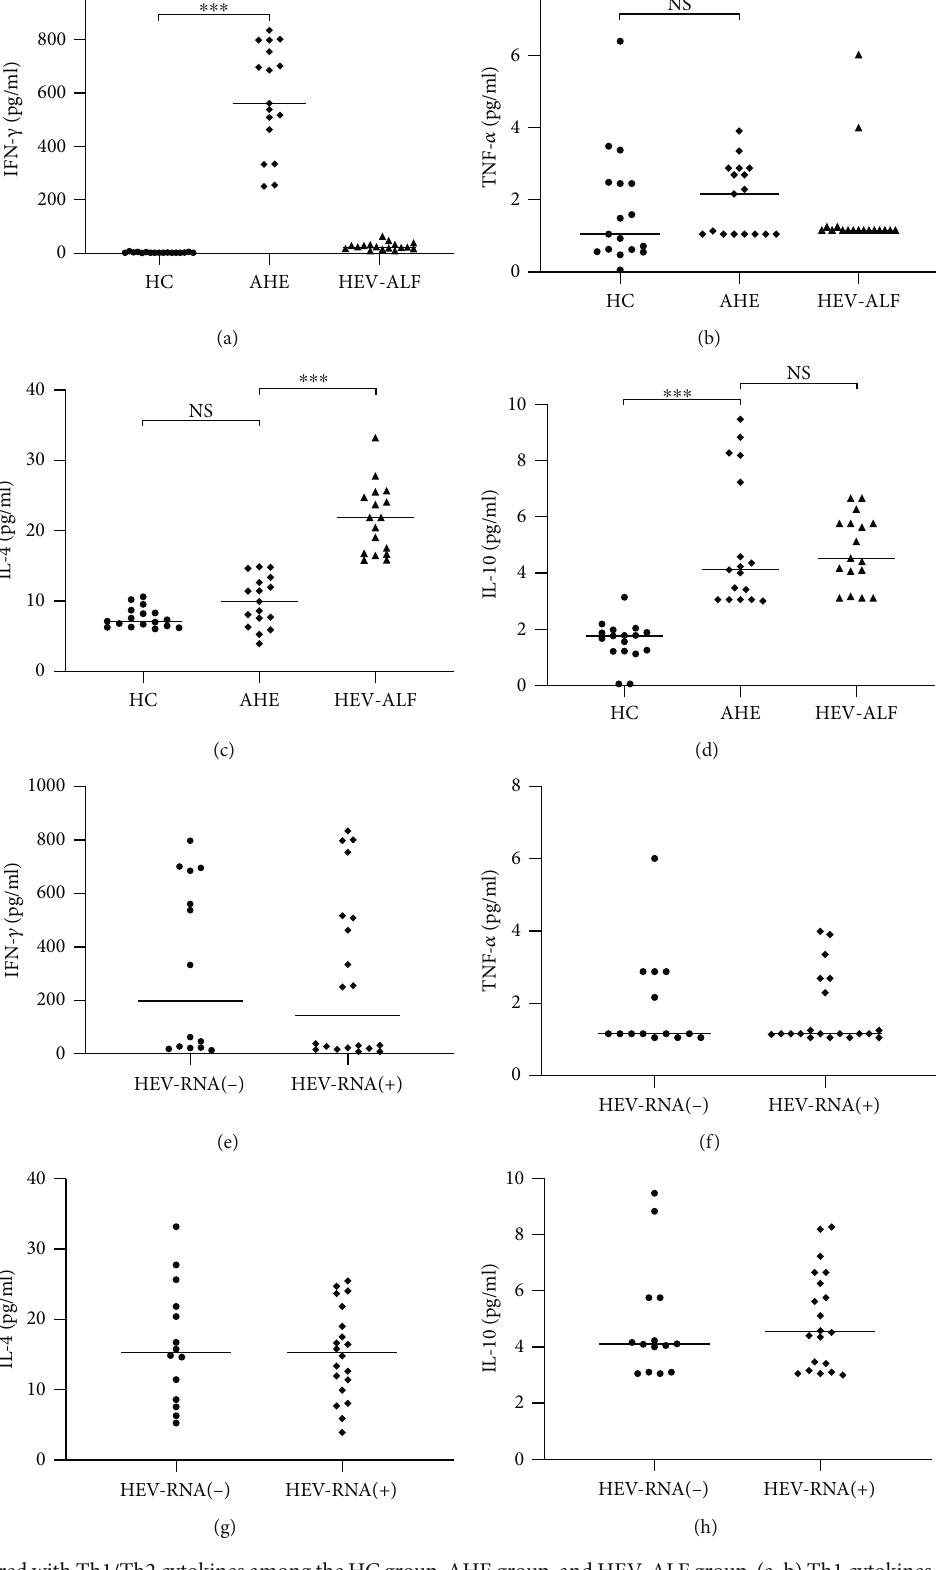
Figure 2: Compared with Th1/Th2 cytokines among the HC group, AHE group, and HEV-ALF group. (a, b) Th1 cytokines (IFN- γ and TNF- α ) and (c, d) Th2 cytokines (IL-4 and IL-10) among the HC group, AHE group, and HEV-ALF group. (e, f) Th1 cytokines (IFN- γ and TNF- α ) and (g, h) Th2 cytokines (IL-4 and IL-10) between the HEV RNA(+) group and HEV RNA(-)